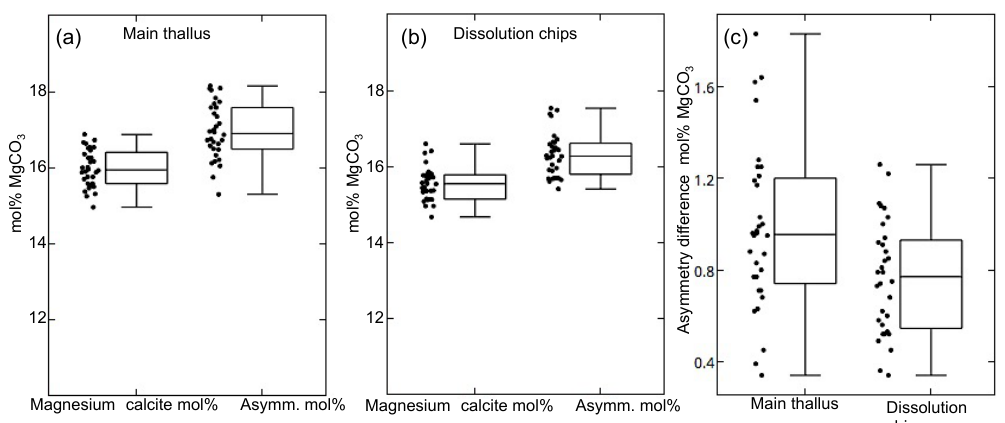
Figure 3. XRD results for main thalli and dissolution chips. (a) The mol% MgCO 3 and asymmetry mol% MgCO 3 for the main thallus. The (b) mol% MgCO 3 and asymmetry mol% MgCO 3 for the dissolution chips. (c) Difference in asymmetry mol% MgCO 3 between the main thallus and dissolution chips indicating a reduction in the higher phases of magnesium calcite after